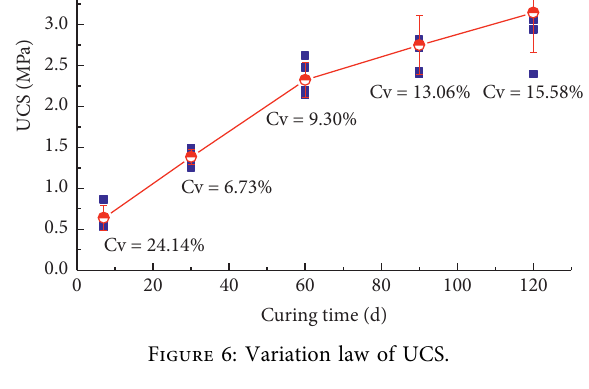
Figure 6: Variation law of UCS.